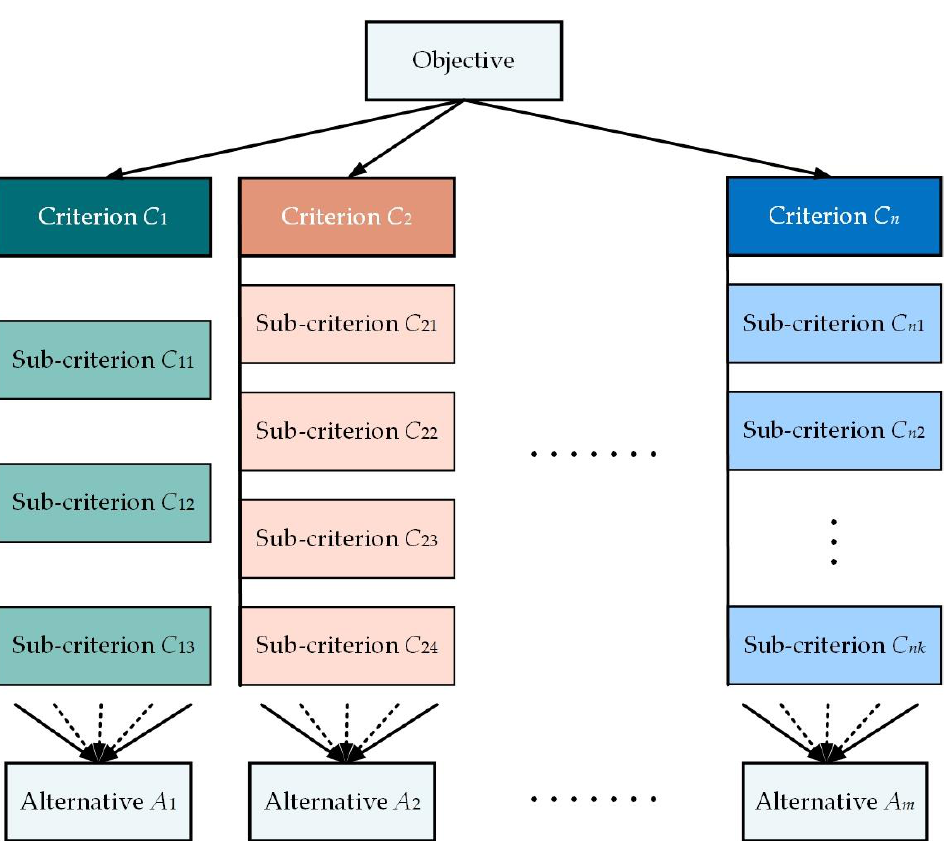
Figure 2. The hierarchical structure.